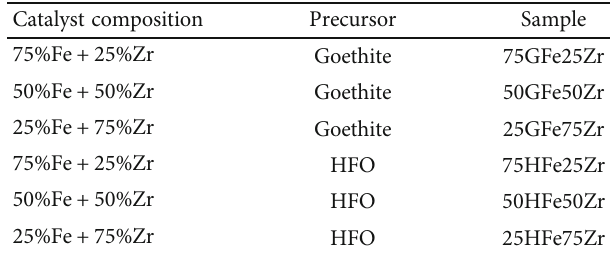
Table 1: Composition of catalysts prepared for the degradation of 4-nitrophenol in water. Catalyst